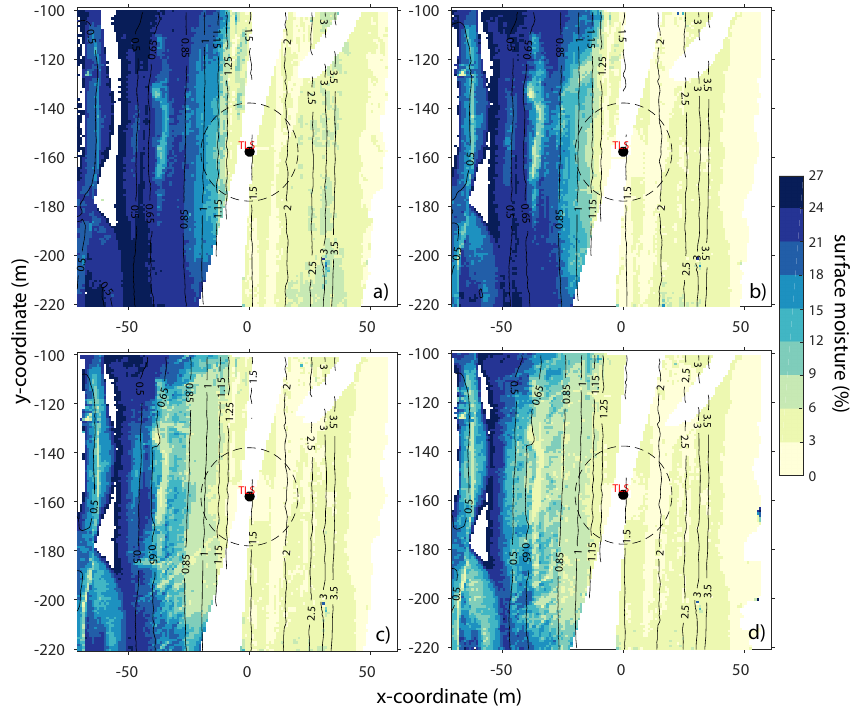
Figure 6. Four surface moisture maps taken over time on 29 September 2015 during falling tide. ( a ) 10:32 a.m.; ( b ) 12:30 p.m.; ( c ) 2:00 p.m. and ( d ) 3:45 p.m. Note that the TLS in the middle of the maps, the sandbar on the left with lighter colours and the trough right next to it with no datapoints because it is